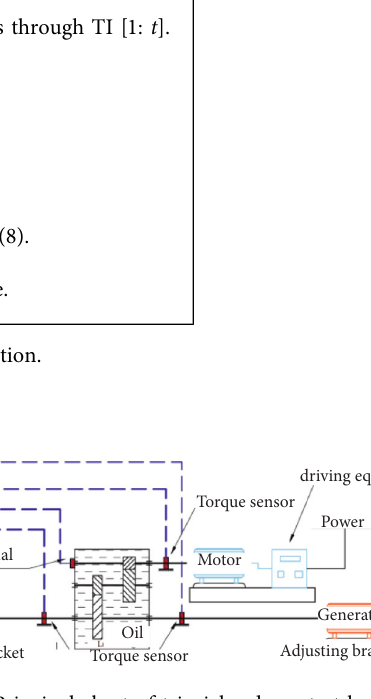
Figure 2: Principal chart of triaxial reducer test bed.